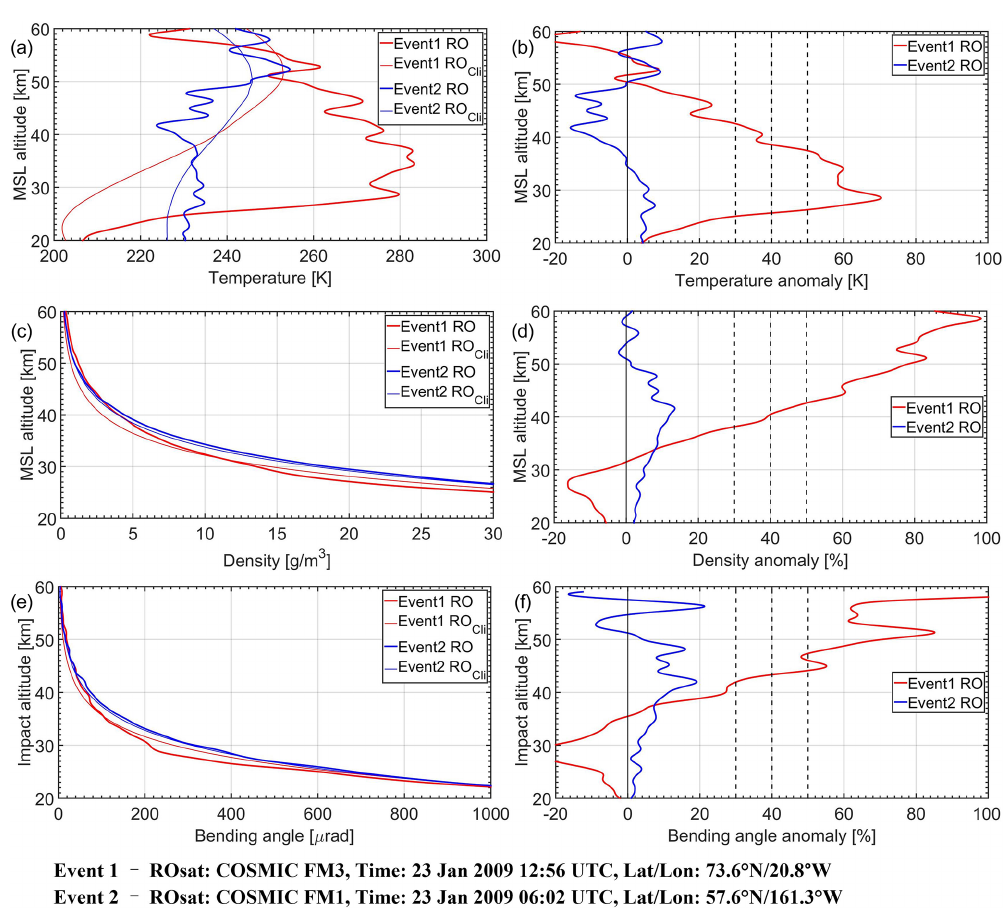
Figure 2. Event 1 and Event 2 temperature (a, b) , density (c, d) , and bending angle (e, f) profiles from RO and their collocated climatological profiles RO Cli (a, c, e) , together with the corresponding anomaly profiles (b, d, f) , the latter computed according to Table 1, (1)–(3).